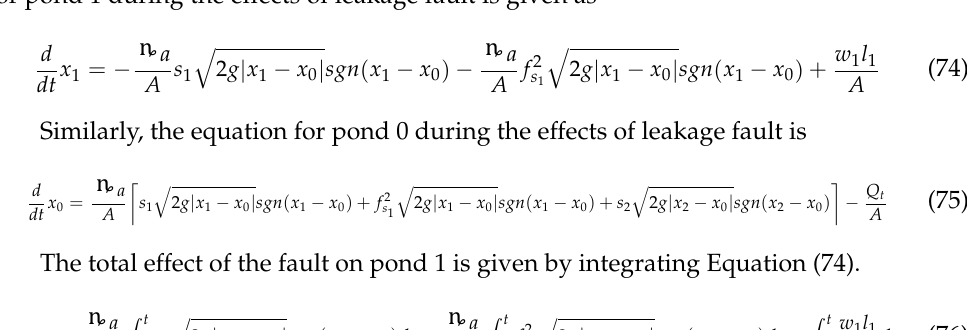
Figure 1. Three-pond hydraulic system.